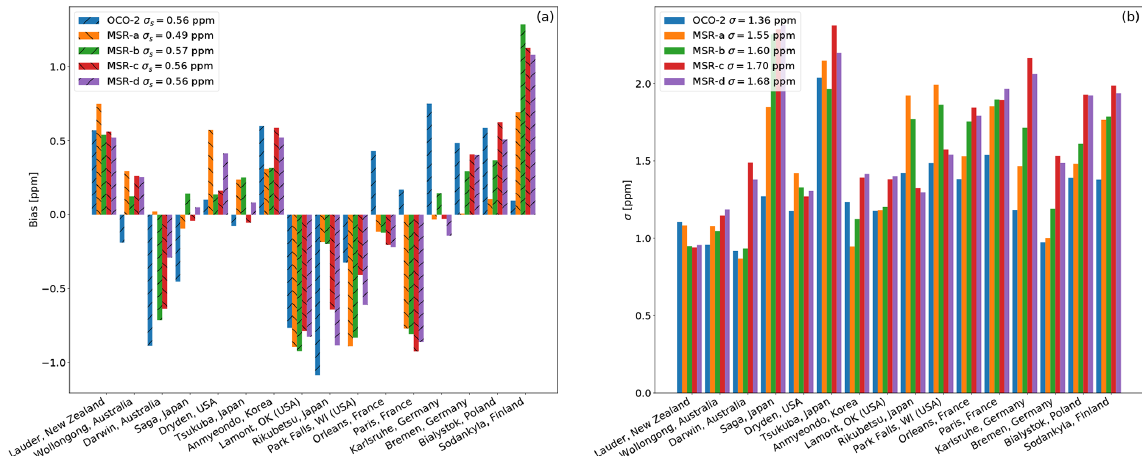
Figure 5. Bias and standard deviation ( σ ) at different TCCON stations for OCO-2 and MSR retrievals. Mean biases are subtracted ac- cordingly for OCO-2 and MSR retrievals to show the bias variation on the same reference level. The station-to-station variability ( σ s ) and single-sounding accuracy ( σ ) are included in the (a) and (b) legends, respectively. Here, MSR measurements are reproduced from OCO-2